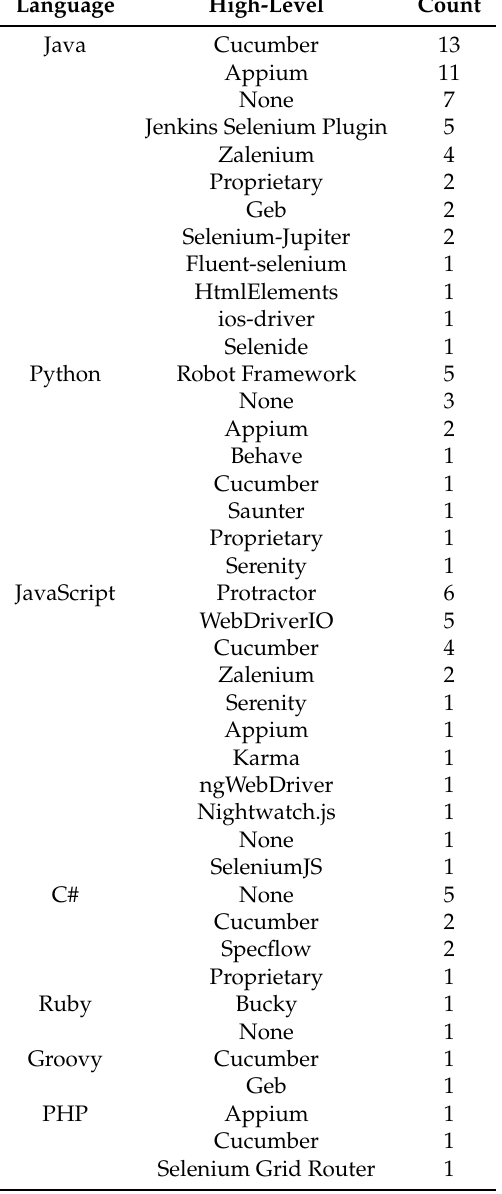
Table A15. 5.b. Which high-level testing framework (which extends or are based on Selenium) do you